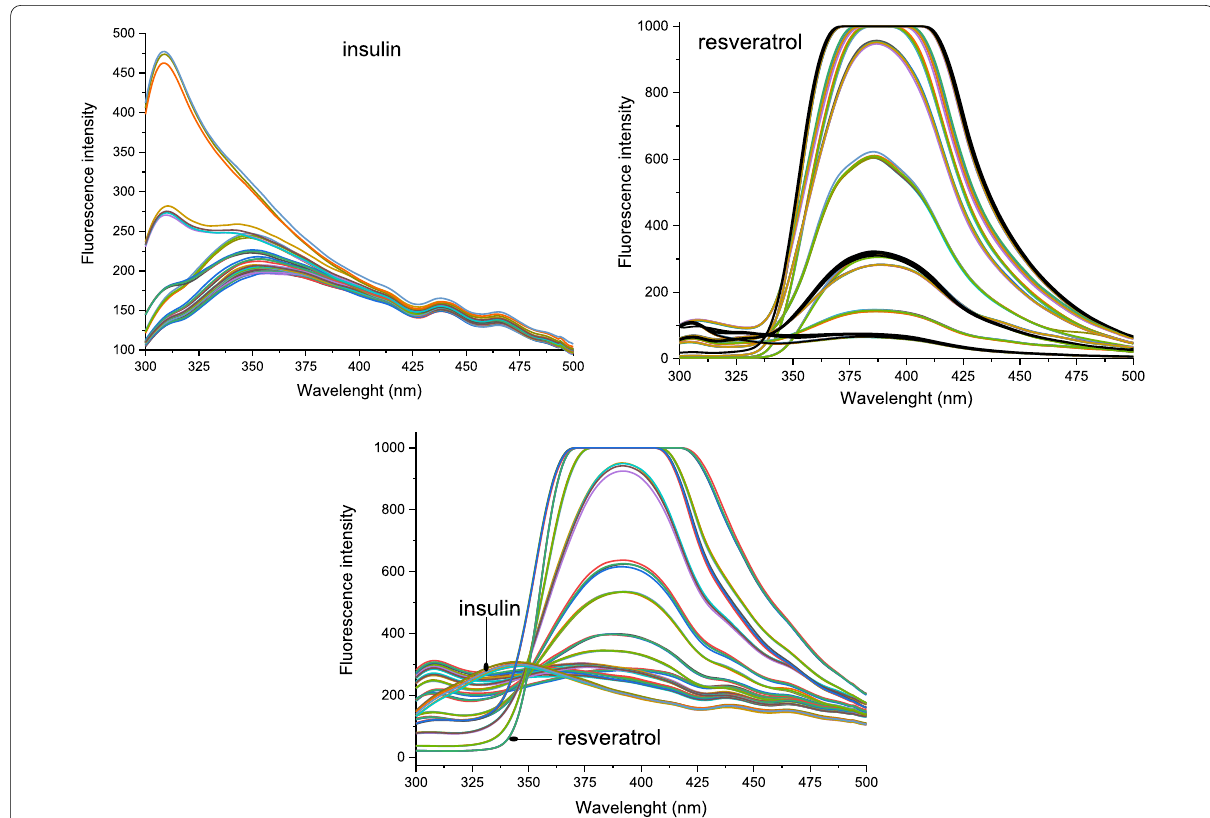
Fig. 3 Emission spectra of a insulin, b resveratrol, and c INS‑RSV solution in different resveratrol ratios: excitation wavelength 280 nm, data pitch 1 nm, bandwidth at 5 nm, medium sensitivity mode, scanning 250 nm/min at 190–500 nm